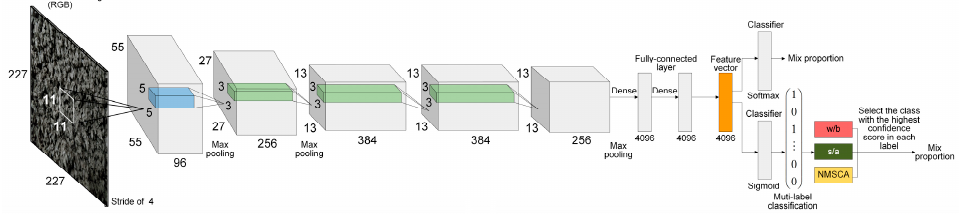
Figure 1. Structure of Net- Ⅰ (above) and Net- Ⅲ (below).